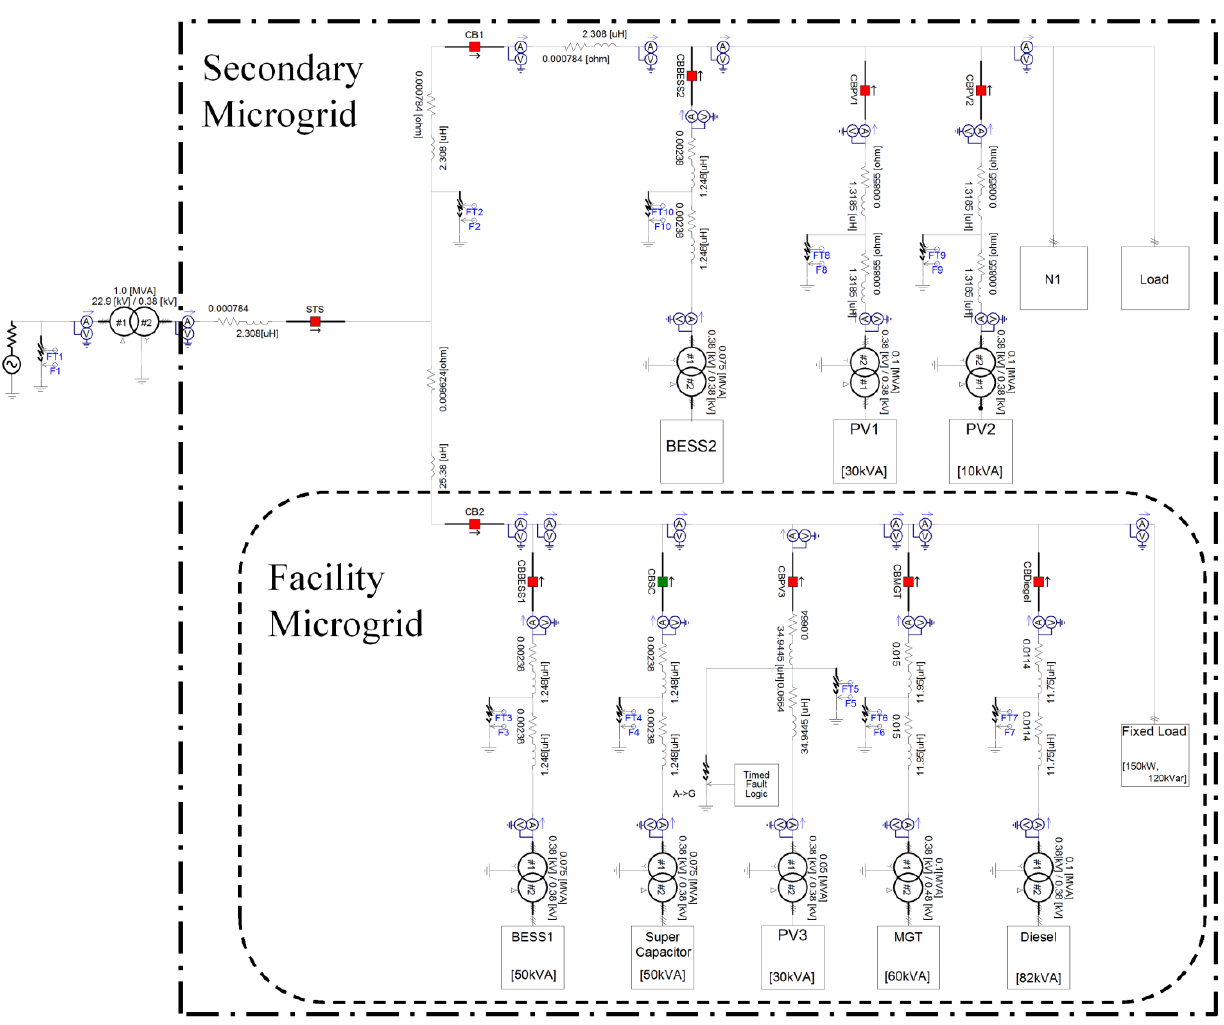
Figure 6. Modeling of microgrids Zones A and B in